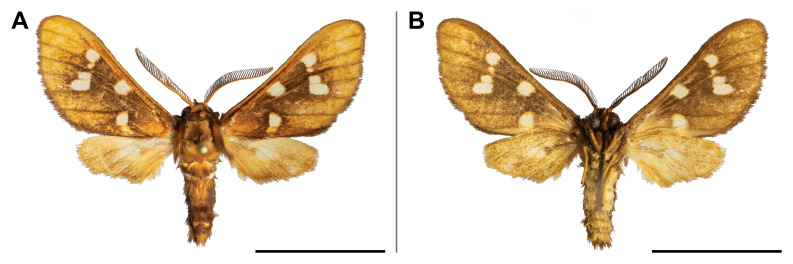
Anapisa
metarctioides (Hampson, 1907). A. dorsal view; B. ventral view. The scale bar represents 1 cm.